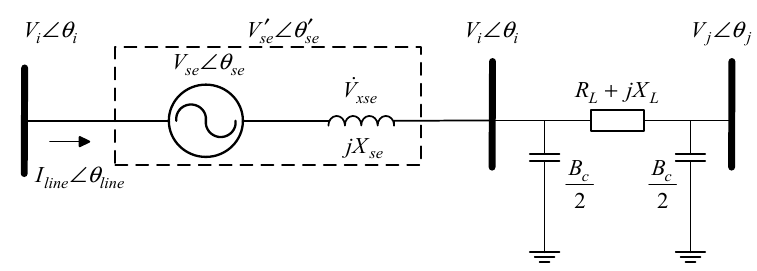
Figure 3. The equivalent circuit of UPFC series side.